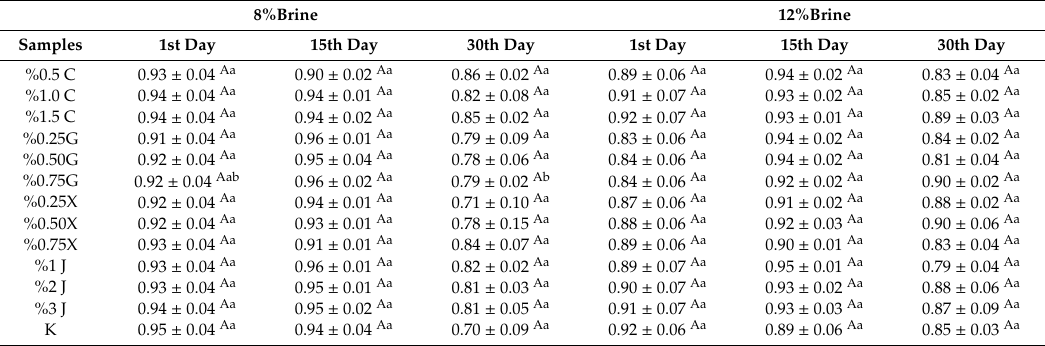
Table 12. Springiness of cheese samples during storage.